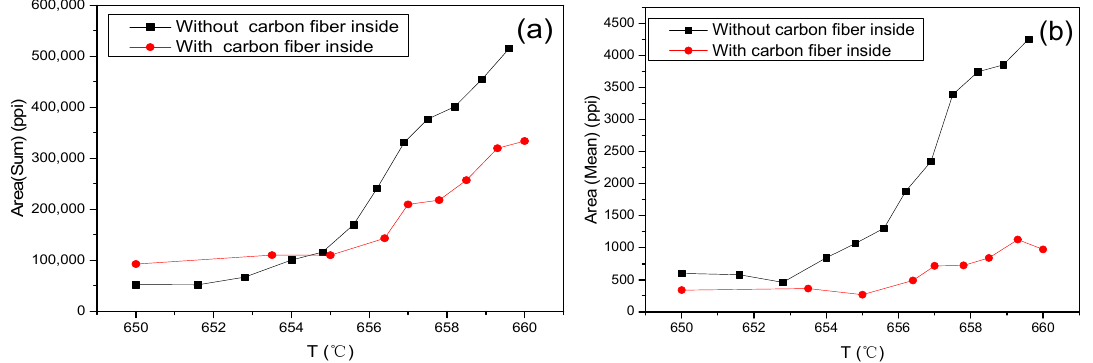
Figure 6. The curve of the cell area of the aluminum foam in the nucleation and growth stage: ( a ) the sum cell area; ( b ) the average cell area.